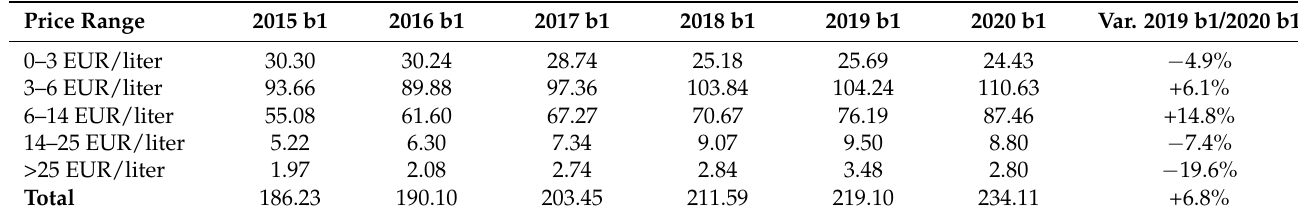
Table 4. Wine sales in value of 0.75 liter bottles by price range (millions of EUR).